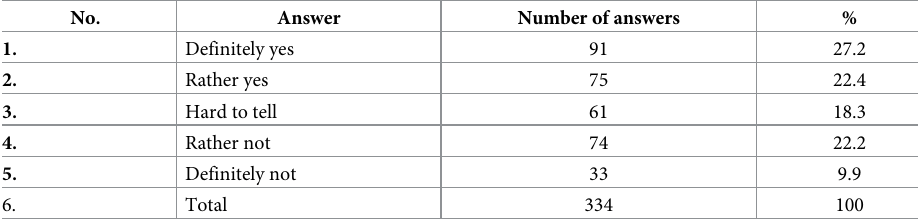
Table 12. The financial dimension of the mother-scientist role conflict. Source: Study by Ewa Krause. No.